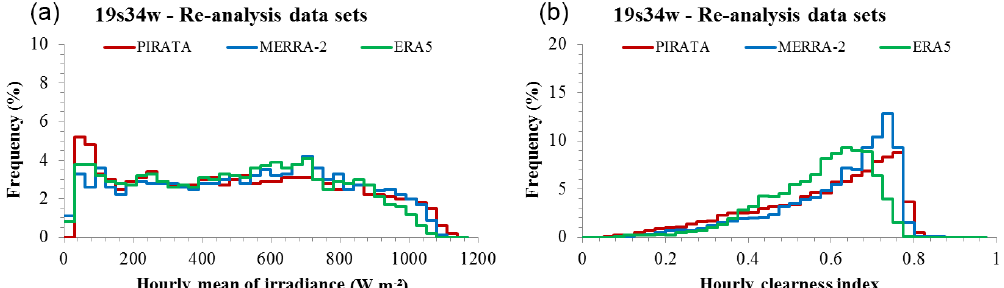
Figure D5. Frequency distributions of PIRATA measurements (red) and data sets (MERRA-2: blue, ERA5: green) at 19 ◦ S, 34 ◦ W for E (a) and KT (b) . If the coloured line is above (below) the red one for a given sub-range of values, it means that the data set produces these values too frequently (too rarely) with respect to the PIRATA